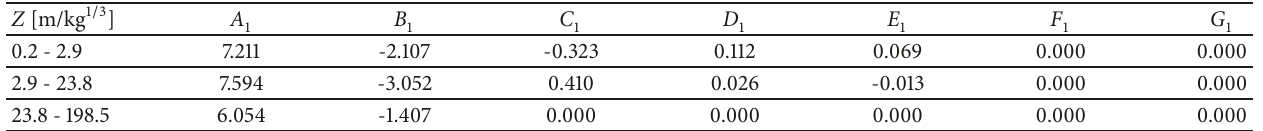
Table 12: Kingery blast